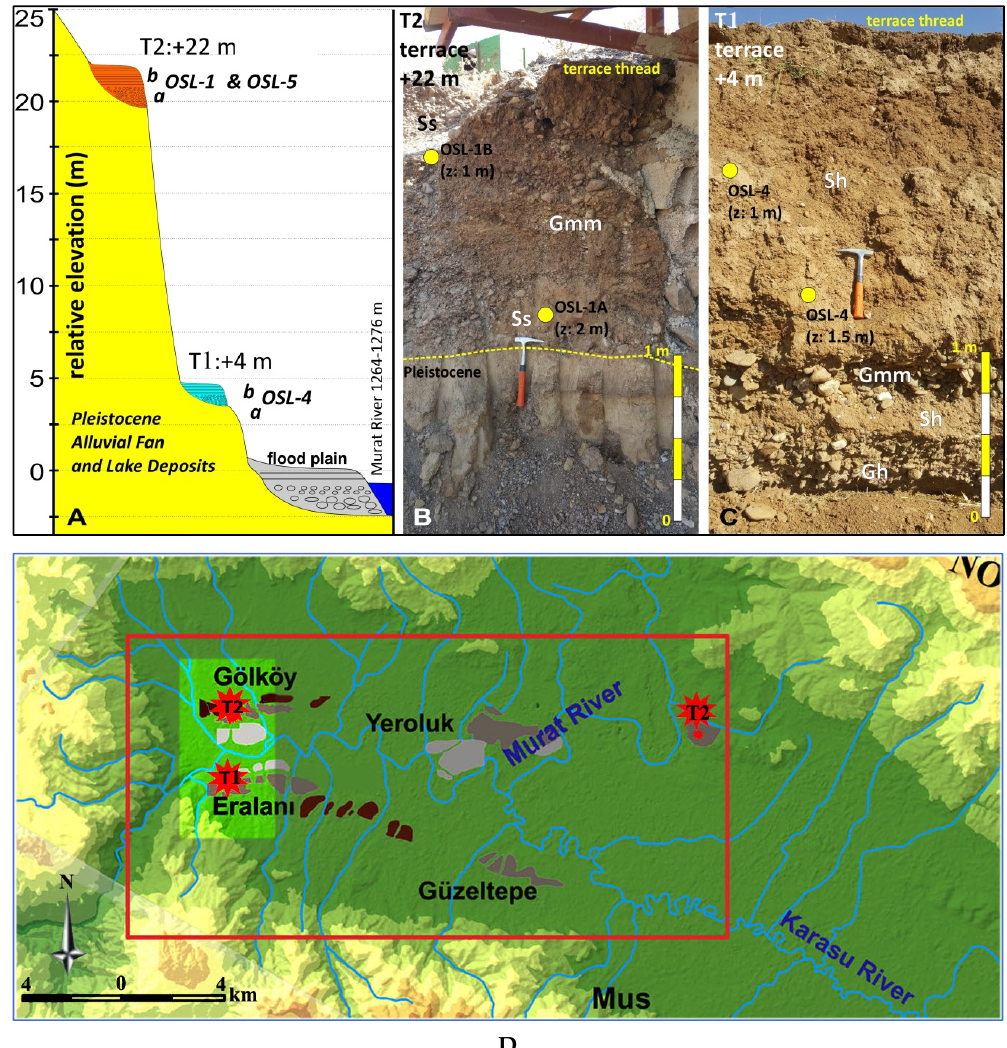
Figure 4. ( A ) Idealized cross-section of T1 and T2. ( B ) Sedimentological structure and OSL sampling location of T2 around Gölköy village, displaying matrix-supported massive gravel ‘Gmm’, interbedded fine to coarse sand ‘Ss’. ( C ) Sedimentological record of T1 and OSL sampling location around Eralanı village, showing horizontal laminated sand ‘Sh’, matrix-supported, horizontal bedded gravels ‘Gh’ and matrix-supported massive gravel ‘Gmm’. ( D ) The locations of the T1 and T2 samples.